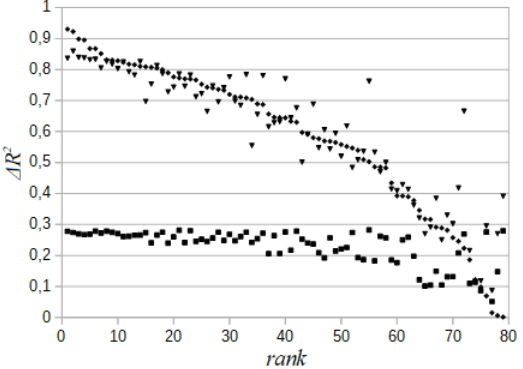
Fig. 6. Results for difference between long models (6a) and short models (6b).